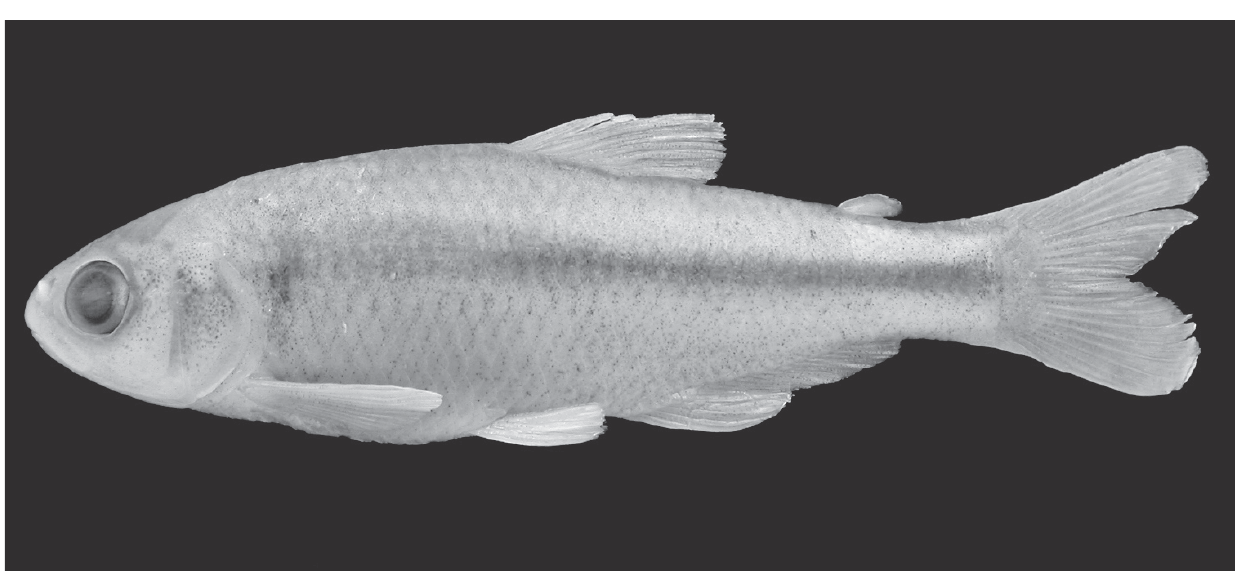
Fig. 1 . Bryconamericus patriciae , holotype, MCP 19615 (47.6 mm SL, male), lateral view. the anterior margin of the maxilla, lack of scales on the caudal fin, a large third infraorbital contacting the preopercle along its posterior and ventral margins, setiform gillrakers, a com- plete laterosensory canal system on the body, and the absence of a glandular pouch on the caudal fin in males. None of the listed characters is unique to the genus and most of them are actually plesiomorphic within Characidae.